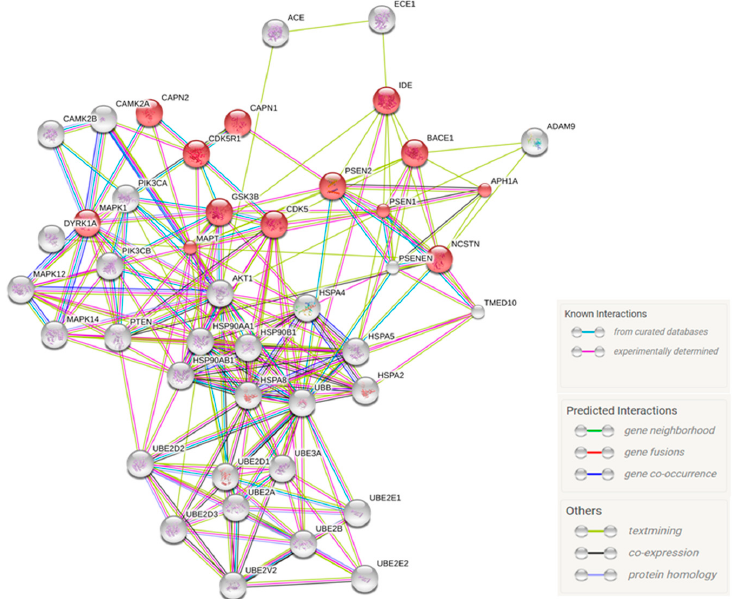
Figure 6. Protein association networks. The protein association network retrieved from STRING using the AD-related genes differentially modulated by CBD in GMSCs. The network circles represent proteins. The lines between the circles show the functional association. Co-expression evidence: black; database evidence: light blue; text mining evidence: yellow; experimental evidence: purple; co-occurrence evidence: blue; neighbourhood evidence: green; fusion evidence: red. The pink circles represent genes statistically correlated to the Alzheimer’s Disease pathway, according to the KEEG database, FDR = 4.19 × 10 15 .